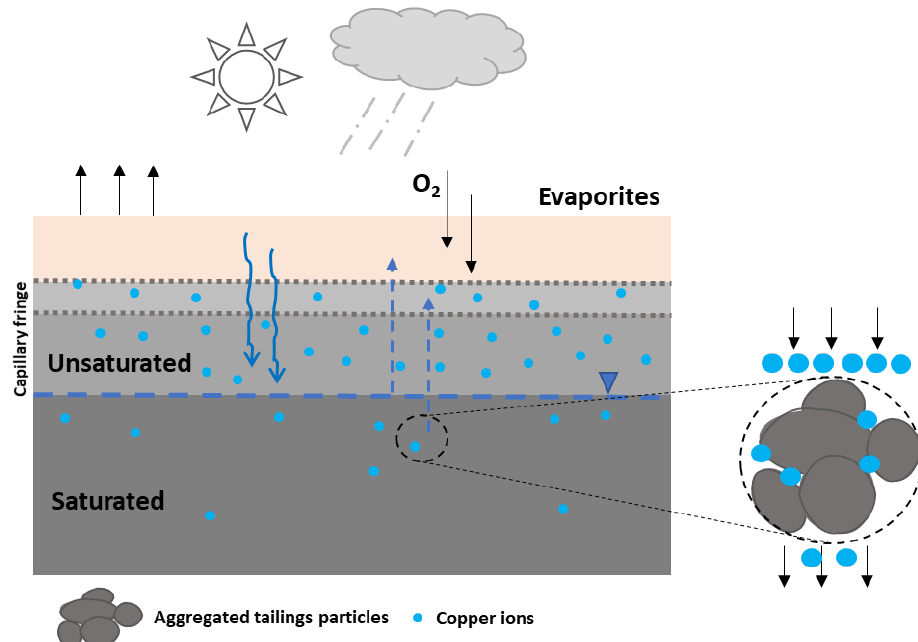
Figure 1. Tailings profile after dewatering and deposition on TSF.